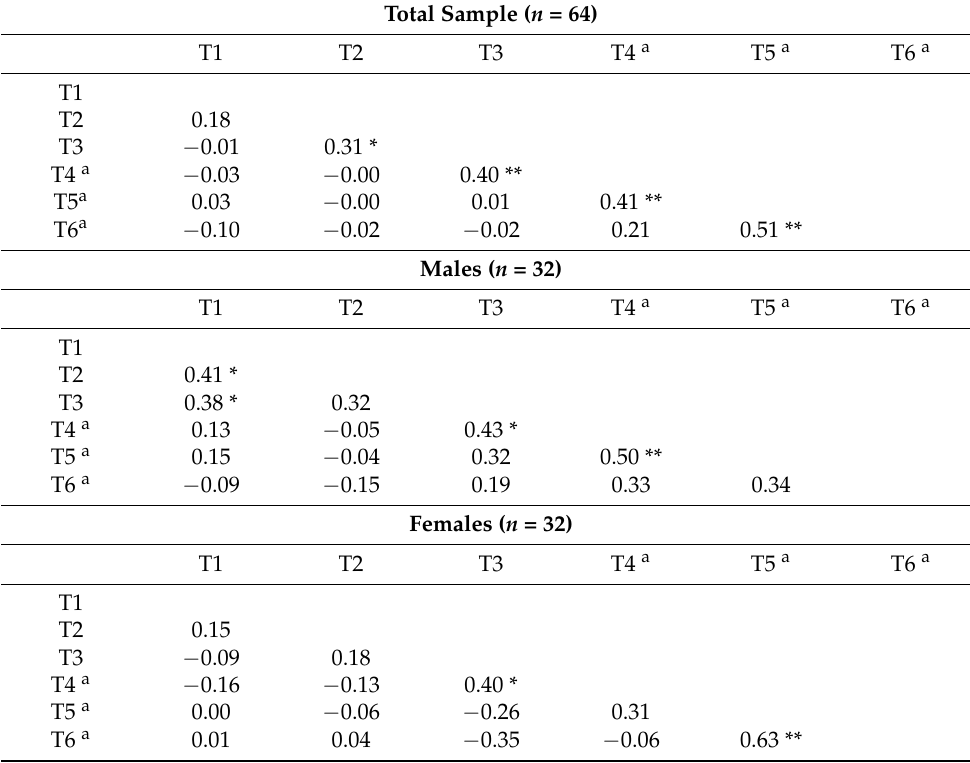
Table 2. Correlations ( r ) matrix for mean SPD at T1 (2000), T2 (2003), T3 (2005), T4 (2010), T5 (2016), and T6 (2020) in the total sample and stratified by males and females,